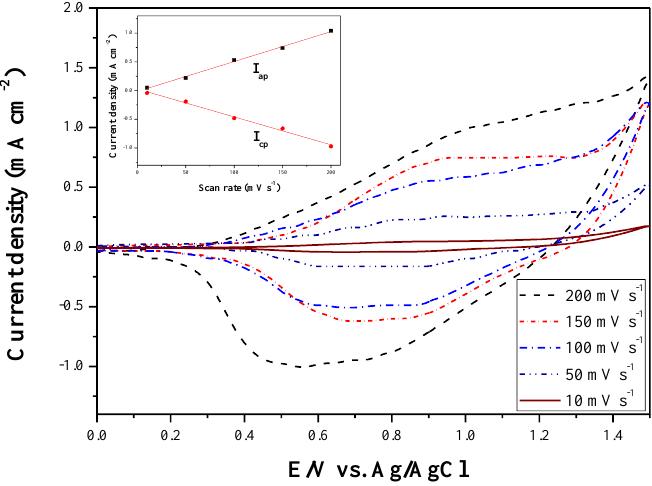
Figure 4. CV curves of the P(DiCP- co -CPDTK) films at different scan rates between 10 and 200 mV s − 1 in 0.2 M LiClO 4 /ACN/DCM solution. Scan rate dependence of the anodic and cathodic peak current densities for P(DiCP- co -CPDTK) films (inset).